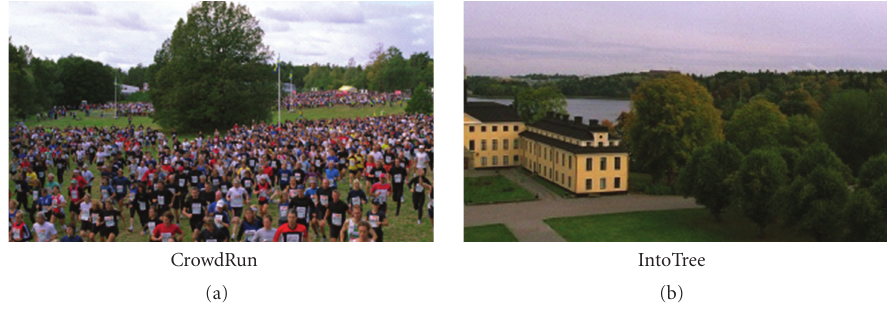
Figure 8: Snapshot of test